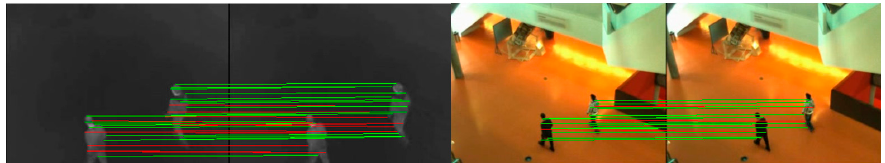
Figure 4. Homologous matched keypoint pairs obtained in infrared images ( the left ) and in visible images ( the right ). The red lines represent mismatches and the green the correct matches.